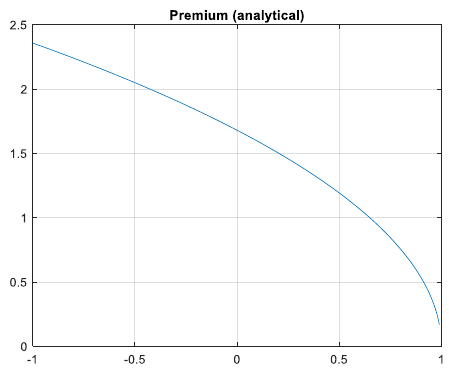
Figure 4. Theoretical exchange option premium with respect to ρ .